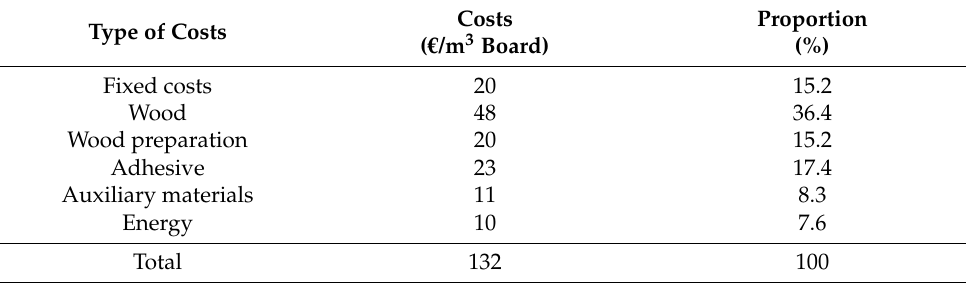
Table 1. Costs for the production of particleboard [1] and their